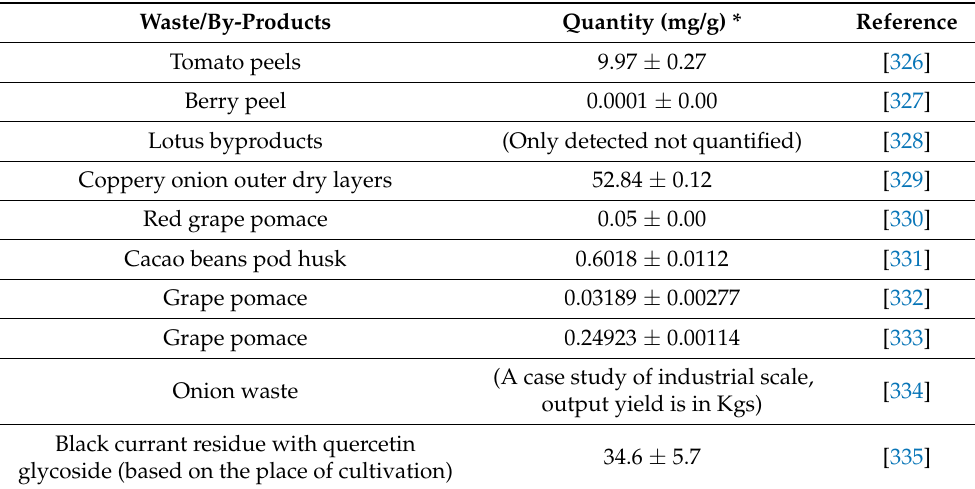
Table 3. Quercetin in food industrial wastes and byproducts.